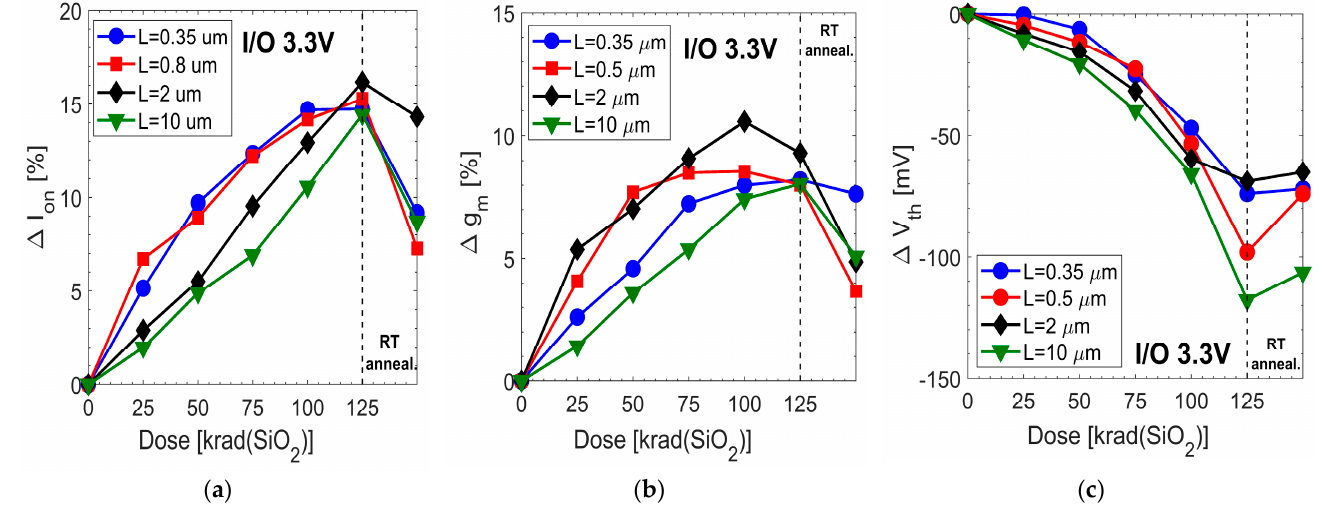
Figure 7. ( a ) Maximum current Δ I on , ( b ) threshold voltage Δ V th and ( c ) transconductance Δ g m as a function of dose for I/O 3.3V nMOSFETs of different channel lengths. The channel width is the narrowest available ( W = 0.8 mm). Transistors measured at room temperature in linear regime ( V ds = 0.1 V) during the irradiation up to 125 krad(SiO 2 ) and after annealing at room temperature for 24 h.